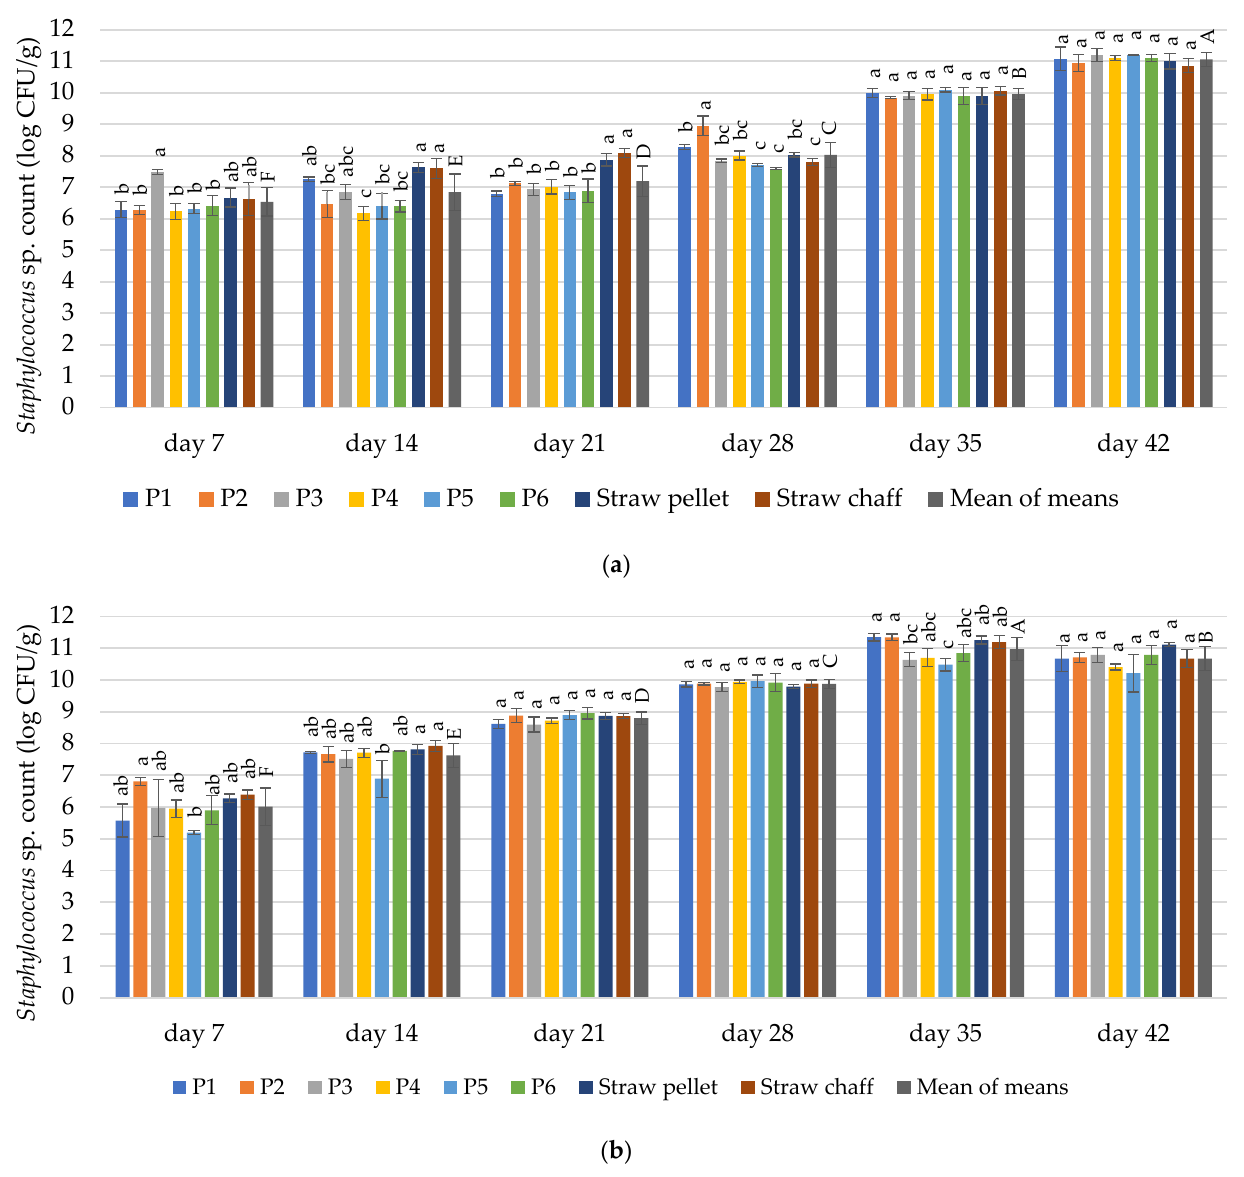
Figure 4. Changes in the count of microorganisms of Staphylococcus sp. in the tested bedding materials: ( a ) 1st experimental cycle; ( b ) 2nd experimental cycle. All values are means of three independent replicates ± SD, except the last bars for each day, which are the means-of-means. For each day, means with a common lowercase letter are not significantly different by the Tukey test at the 5% level of significance. For different days, means-of-means with a common uppercase letter are not significantly different by the Tukey test at the 5% level of significance. Pairwise comparisons between materials are presented only for observations from the same day. Pairwise comparisons between days are presented only for means-of-means. No pairwise comparisons between cycles are presented.